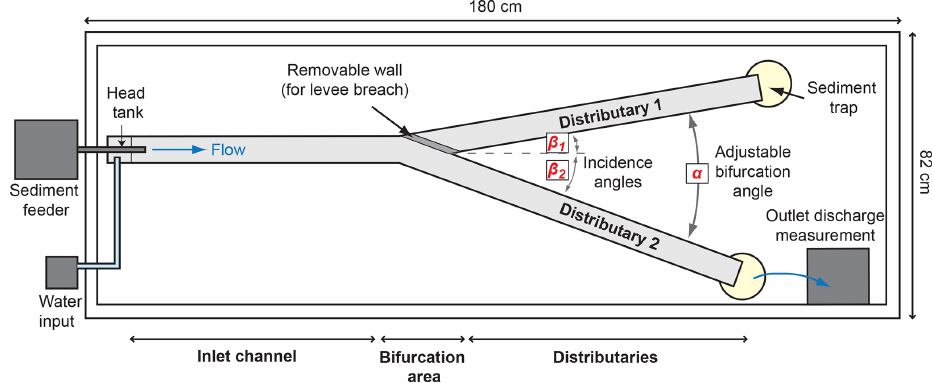
Figure 2. Overhead view of the experimental setup together with the different angles considered and the levee breach setup. Table 1. List of experiments and associated